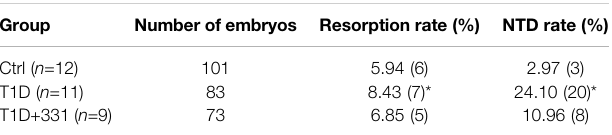
Dataaremean±SEMunlessotherwiseindicated.Ctrlgroupfednormaldiet,T1Dgroup were given STZ before pregnancy. *Signi fi cant differences compared with the other two groups as analyzed by the turkey test or T test.